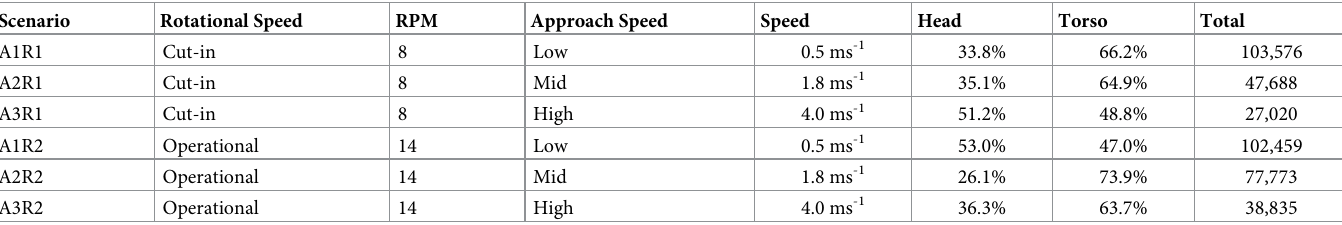
Table 1. The total number of collisions in each scenario, and the % of those that were to the head or torso of the seal. The scenarios refer to the codes, where A1R1 represents the scenario for the slowest approach speed (A1) and the cut-in rotational speed (8RPM) (R1). Scenario Rotational